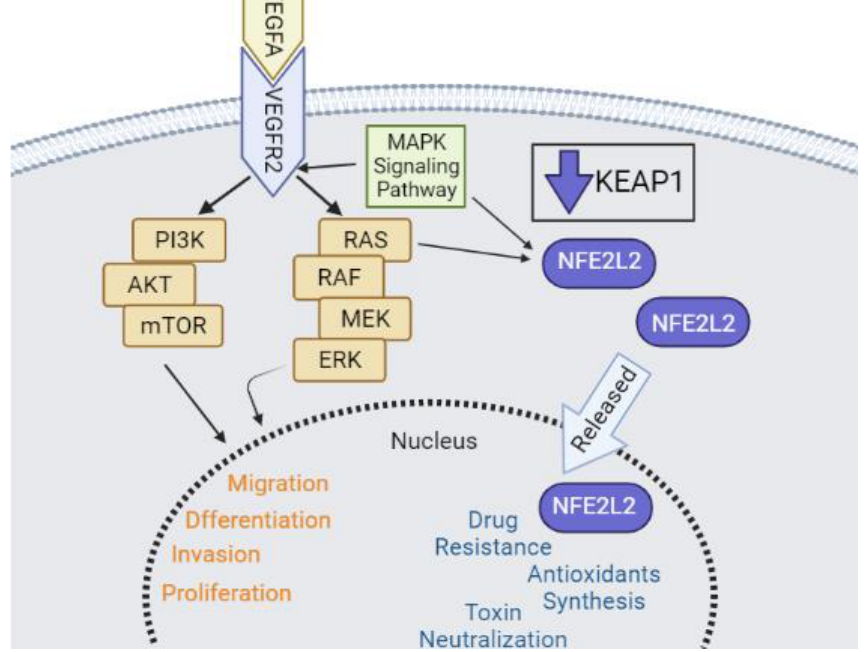
Figure 6. Pathways of action of the VEGFA , KRAS, and NFE2L2 genes. VEGFA binds to its membrane receptor VEGFR2 leading to activation of the signaling cascade RAS/RAF. NFE2L2 is regulated by the KEAP1 protein which, when inhibited, increases the levels of NEF2L2 that is released into the cell nucleus. The MAPK pathway is also related to the VEGF, KRAS and NFE2L2 pathway. Adapted: Cuzziol et al., 2020 [35].